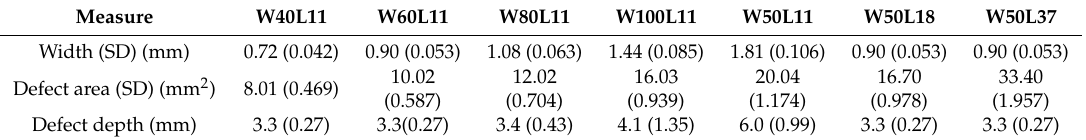
Table 2. Defect depth, width, and area in absolute values as mean and standard deviations.